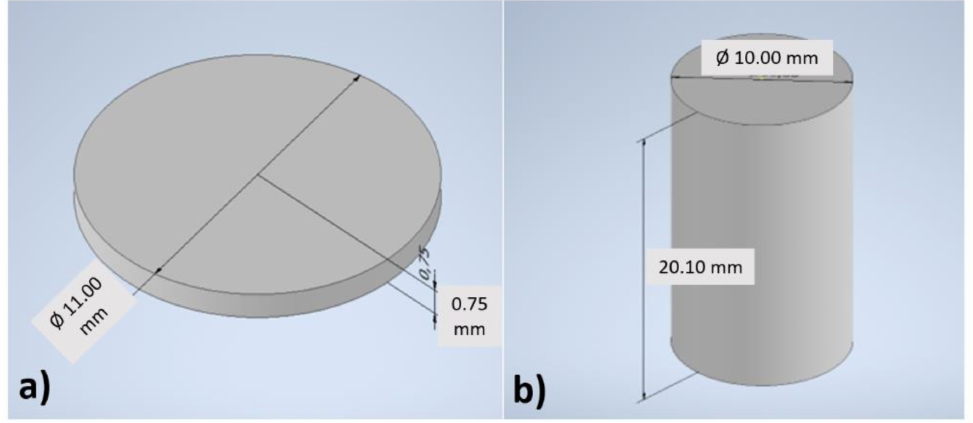
Figure 1. Computer-aided design (CAD) models of the ( a ) base and ( b )